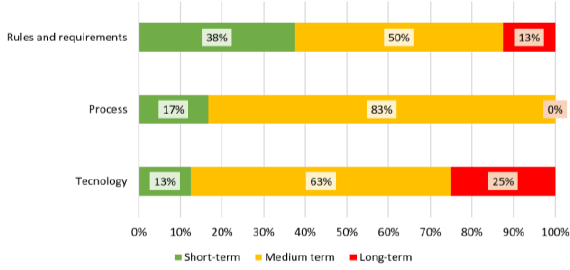
Figure 8. Classification of the EUnet4DBP